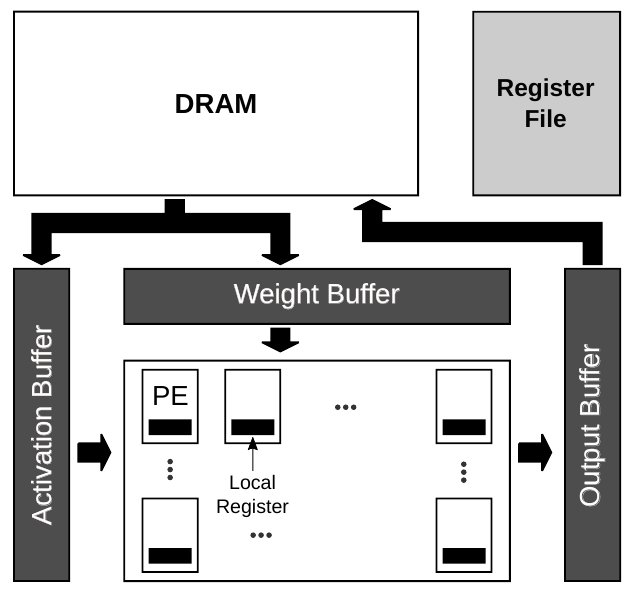
Figure 10. Generic memory hierarchy for a DNN